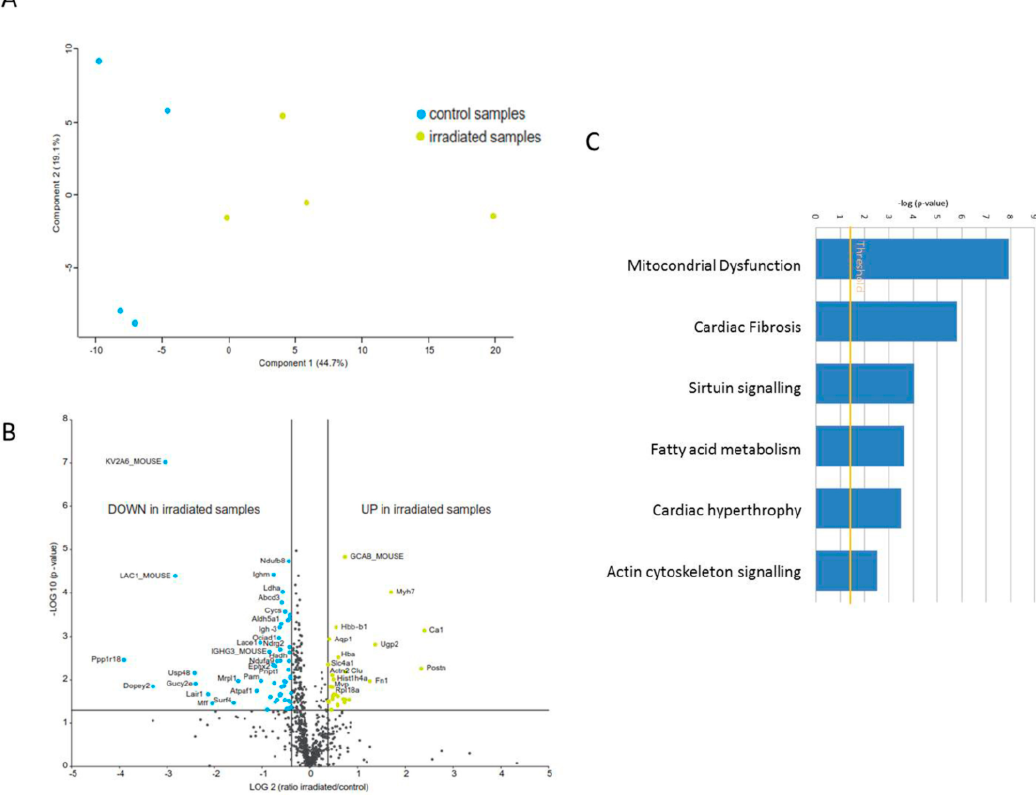
Figure 1. Proteome analysis of mitochondrial proteins in the irradiated heart. ( A ) Principal component analysis (PCA) based on all proteomic features. ( B ) Graphical representation of quantitative proteomics data of cardiac mitochondria after chronically exposure to accumulated doses of 6 Gy. Proteins are ranked in a volcano plot according to the − log10 of their statistical p -value ( y -axis) and log2 fold change ( x -axis). The yellow points represent the significantly more abundant proteins in cardiac mitochondria after irradiation, the blue points represent the significantly less abundant proteins. ( C ) The most significant canonical pathways altered by irradiation. The analyses were generated through the use of IPA (QIAGEN Inc., https: // www.qiagenbio-informatics.com / products / ingenuity-pathway-analysis). Bars indicate canonical pathways and the y -axis displays the − (log p) enrichment significance. Taller bars are more significant than shorter bars.